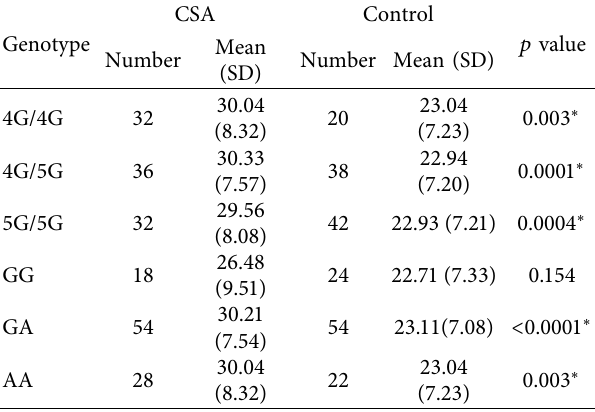
Table 10: Comparison of PAI level (ng/ml) according to 4G/5G and -844G/A polymorphism in the CSA cases and control